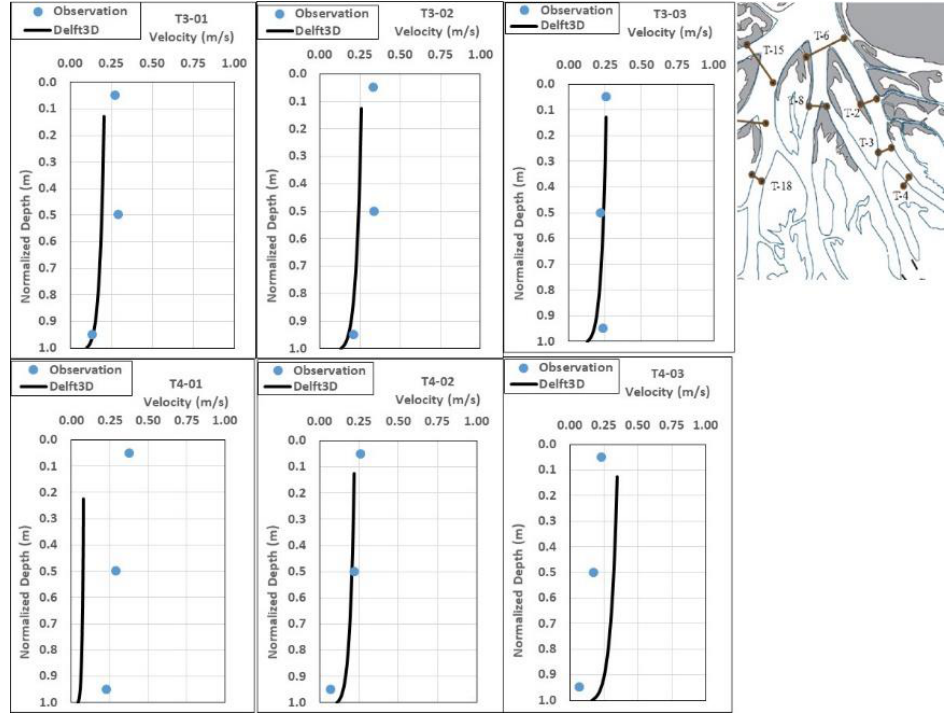
Figure 5. Validation results showing comparison of modeled and observed streamwise velocities at East Pass.